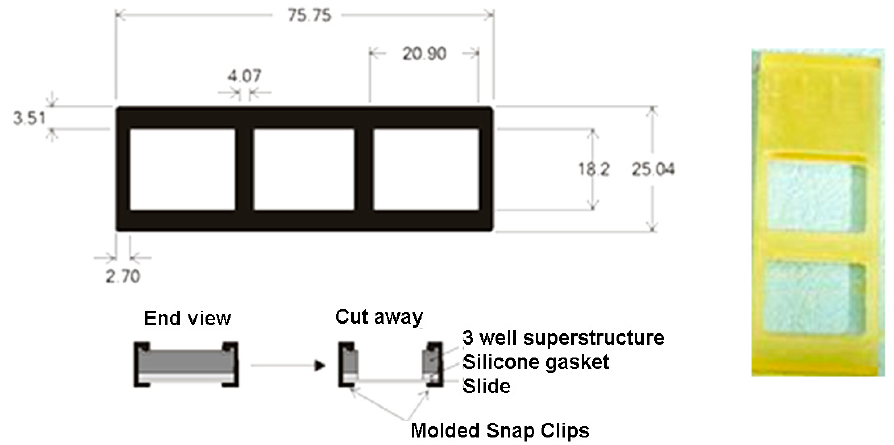
Figure 4. Scheme of printed slides in 2 subarrays, with slide holder closing gasket (digits in mm).